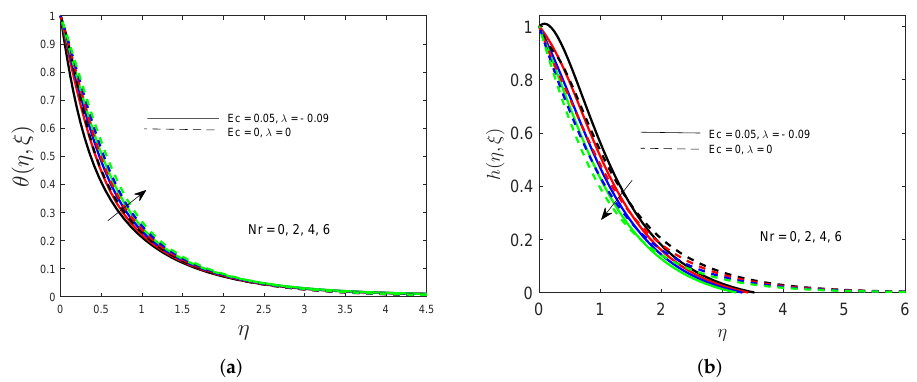
Figure 5. The impacts of thermal radiation on ( a ) temperature and ( b ) concentration profiles. The Soret effect is observed in Figure 6a–c. Higher values of the thermophoresis parameter lead to increases in all three flow profiles. This can be explained by the fact that the exponentially stretching sheet causes an upward shift in the temperature gradient. particles in the cold region, making the three flow variables increase. Similar results were obtained by [34].